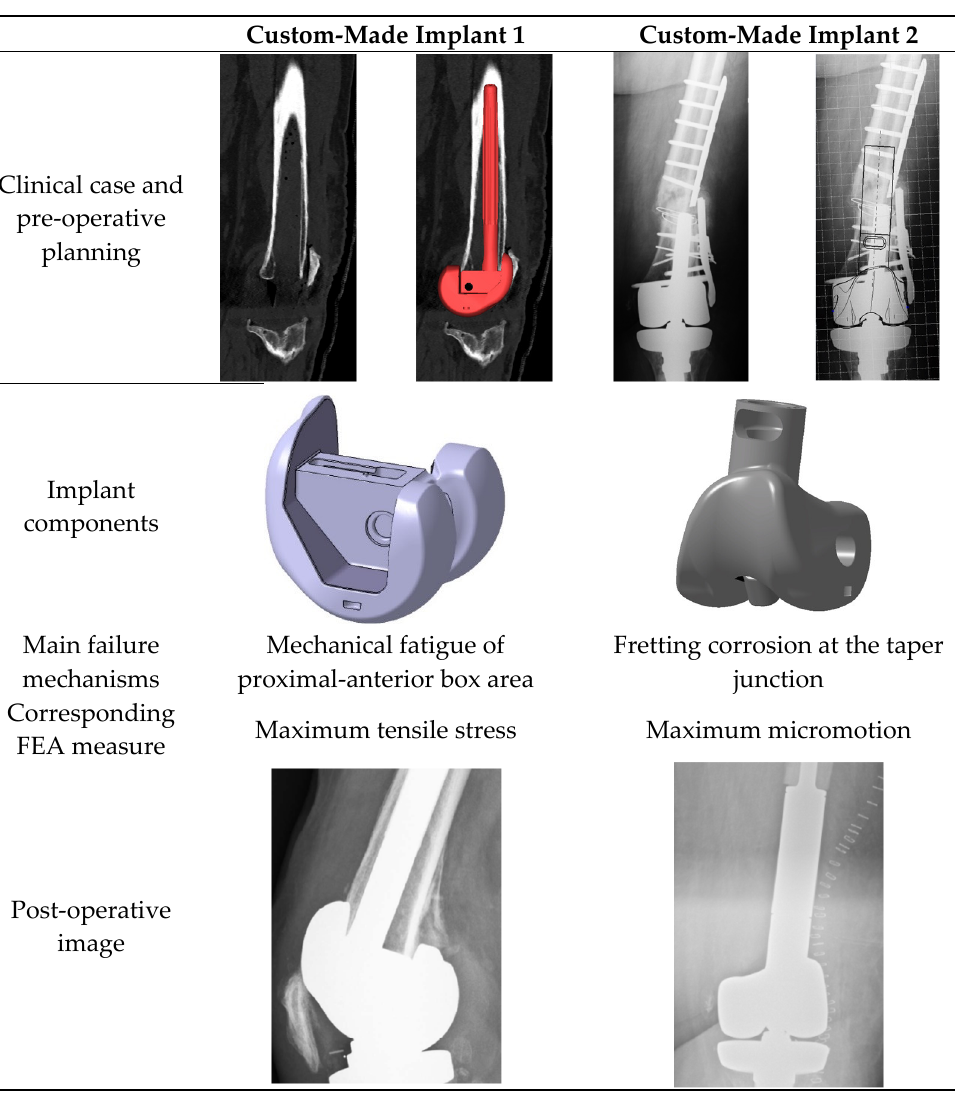
Table 1. Overview of the custom-made